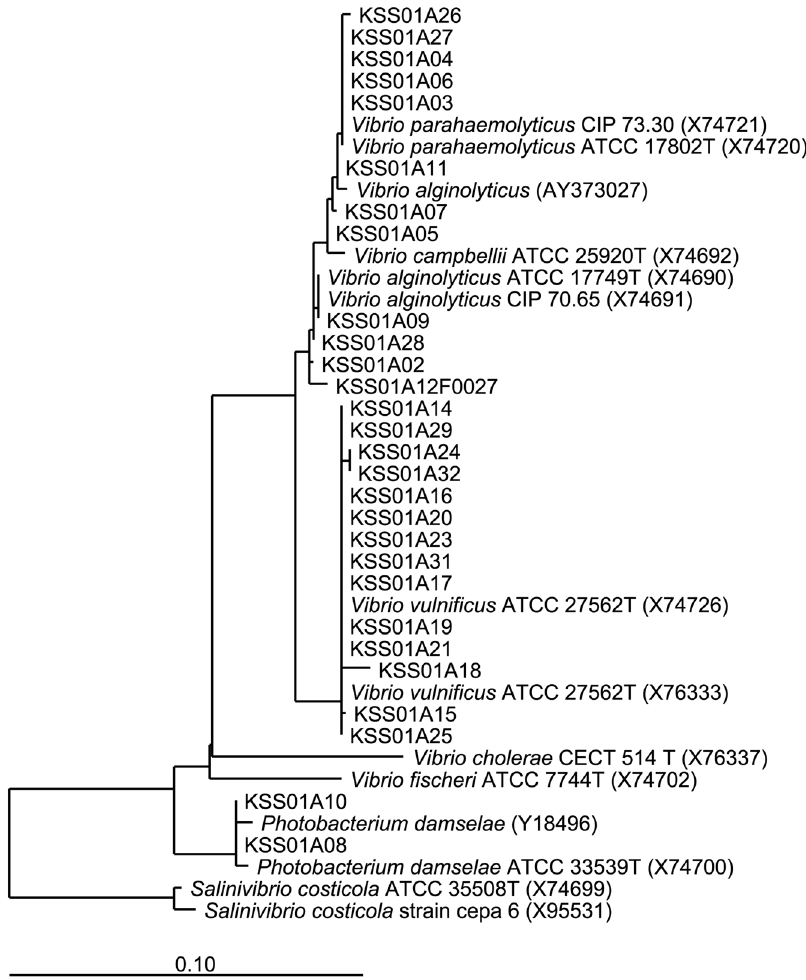
Figure 2. 16S rRNA sequencing analysis of a subset of Vibrio isolates tested.